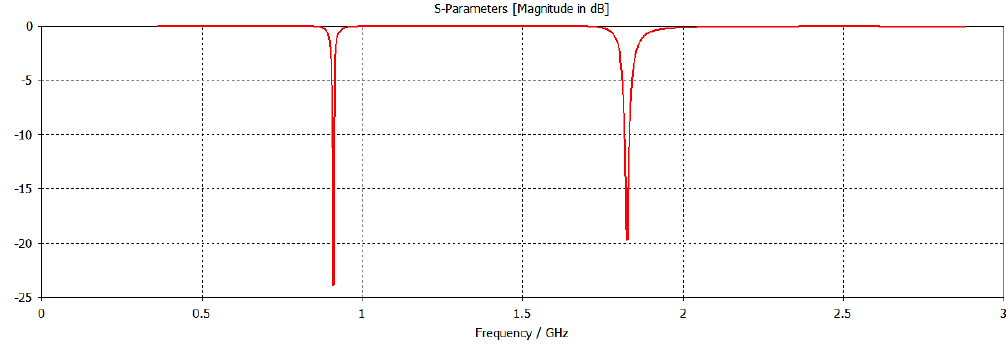
Figure 5. Return Loss (L-slot